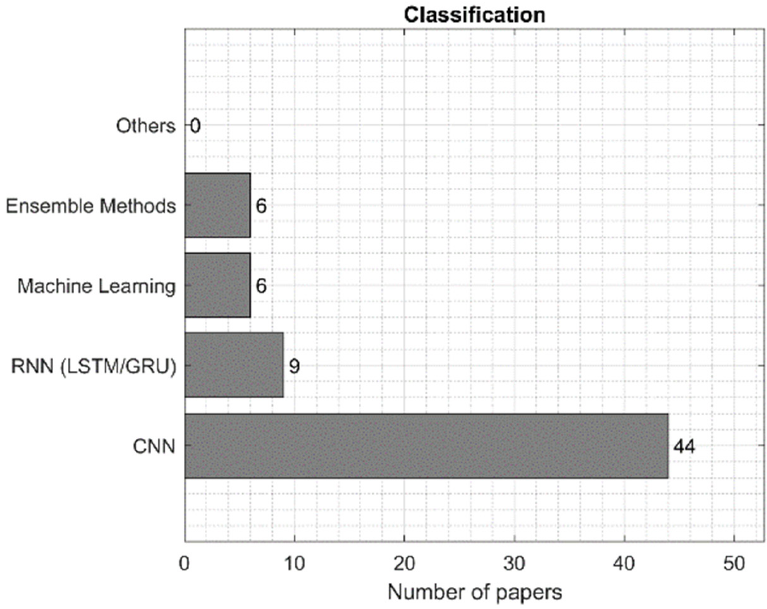
Figure 9. Classification methods used in the analyzed articles.